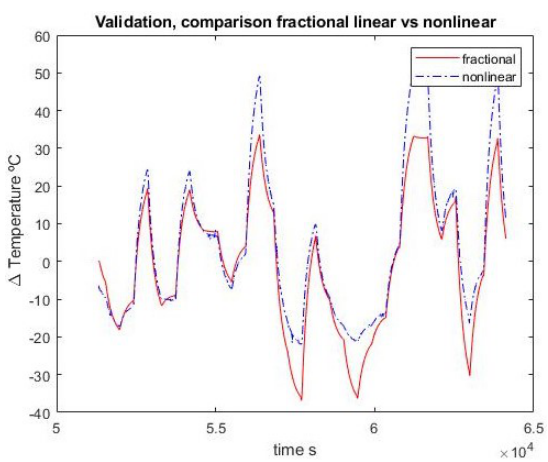
Figure 12. Second-order linear ordinary model. Validation.